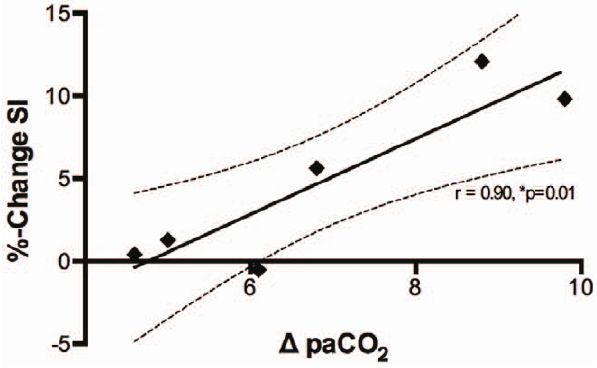
Figure 3. Correlation of myocardial SI in oxygenation-sensitive CMR images to changes in paCO 2 . Differences in paCO 2 (mmHg) are plotted against the % change in myocardial SI (n=6). The data shows excellent linear correlation (r=0.90, p =0.010). The dashed lines represent the 95% confidence interval.